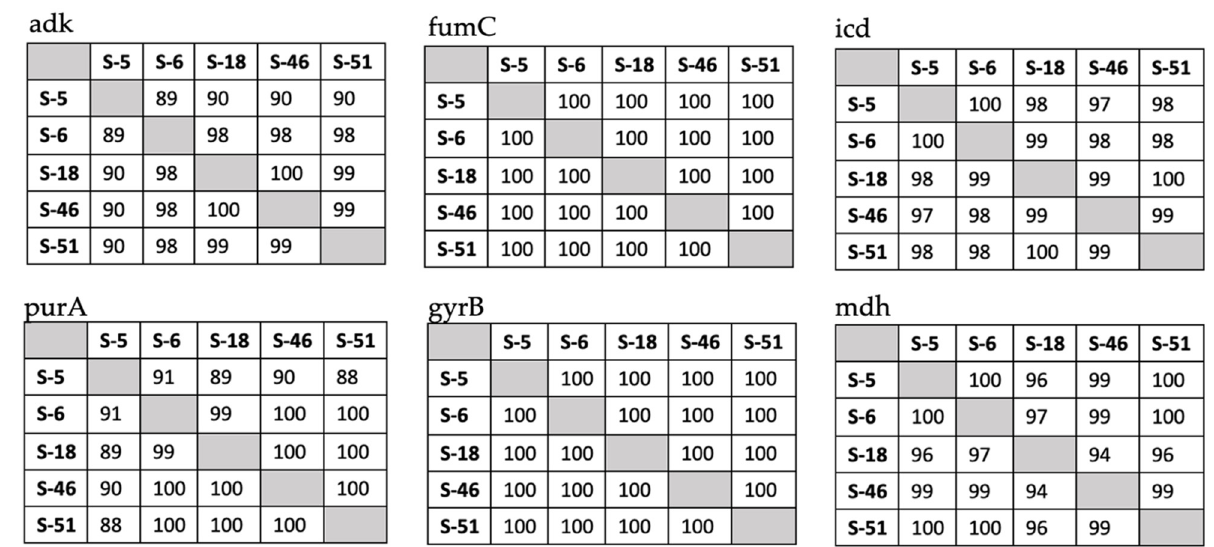
Table 5. PCR results of chicken (56) and human (9) samples for detection resistance-associated genes.